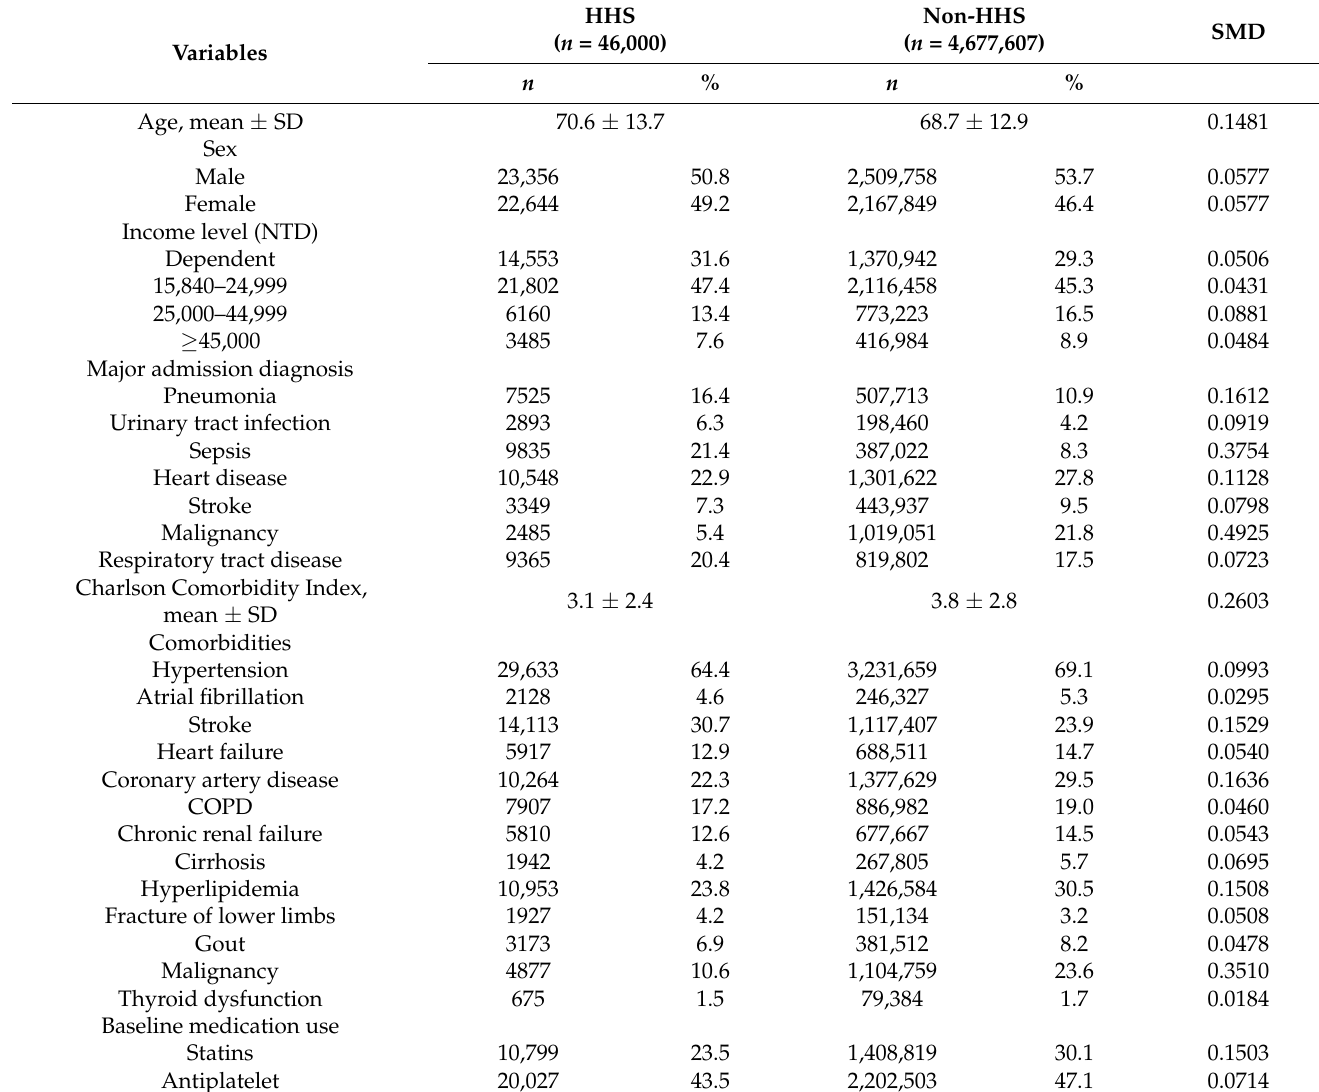
Table 1. General characteristics of admission records with and without